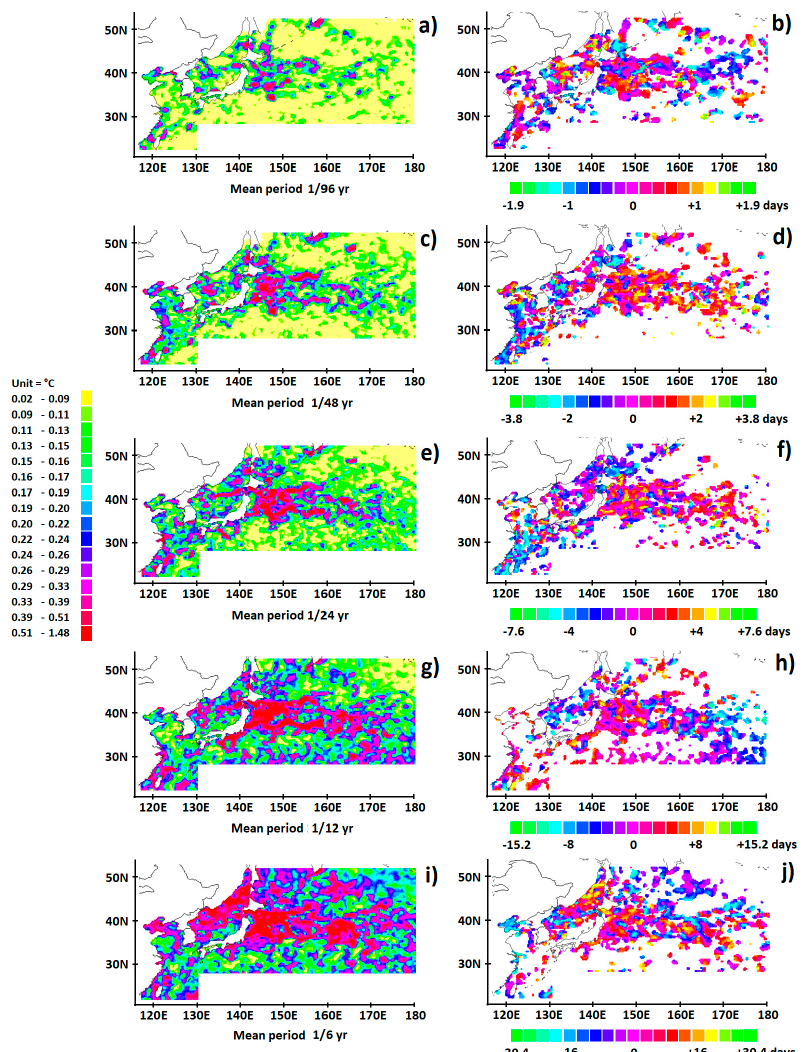
Figure 7. Same as Figure 3 for the amplitude ( a , c , e , g , i ) and the phase ( b , d , f , h , j ) of SST whose anom- alies are negative when the time lag is zero. Time lags in ( b , d , f , h , j ) are expressed in relation to